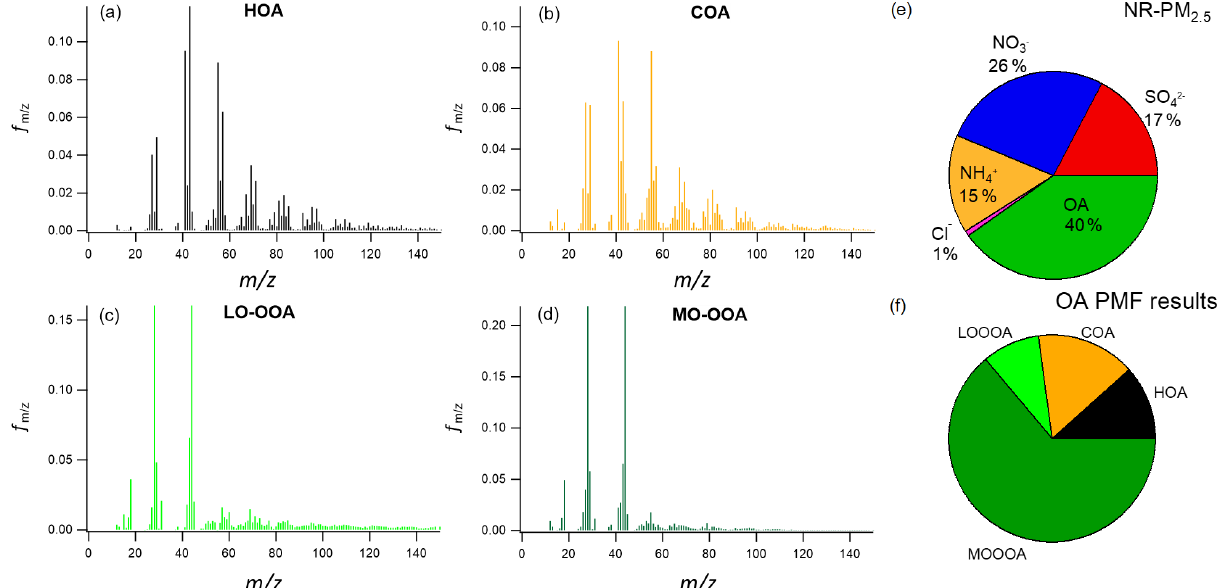
Figure 6. Profiles of organic aerosols of the factors from OA PMF analysis: (a) HOA, (b) COA, (c) LO-OOA and (d) MO-OOA. (e) The mass fractions of NR-PM 2 . 5 . (f) The mass fractions of OA sources. HOA is hydrocarbon-like organic aerosol, COA is cooking organic aerosol (COA), LO-OOA is less oxygenated organic aerosol (LO-OOA) and MO-OOA is more oxygenated organic aerosol